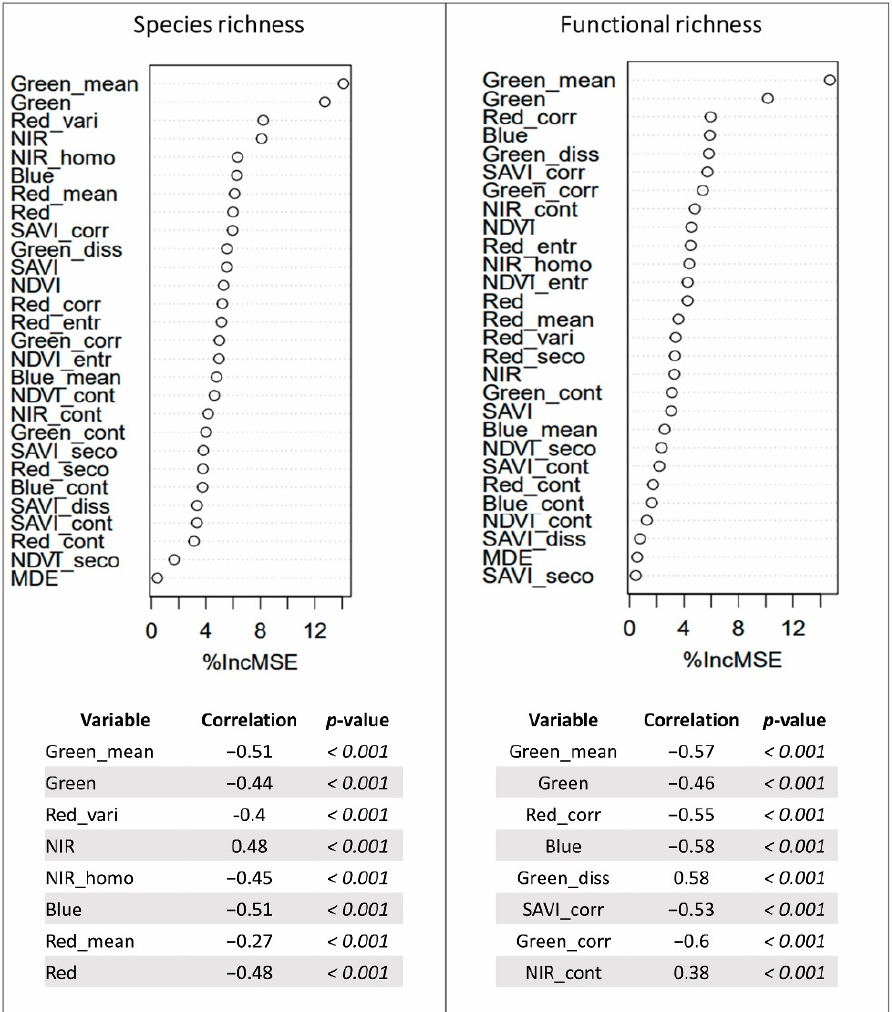
Figure 3. Classification of the importance of explanatory variables in estimating tree species richness and functional richness based on the percentage increase in mean square error (% incMSE) when the explanatory variable is removed. Pearson’s correlation coefficient to evaluate the type of relationship between the most important predictors and tree species richness and functional